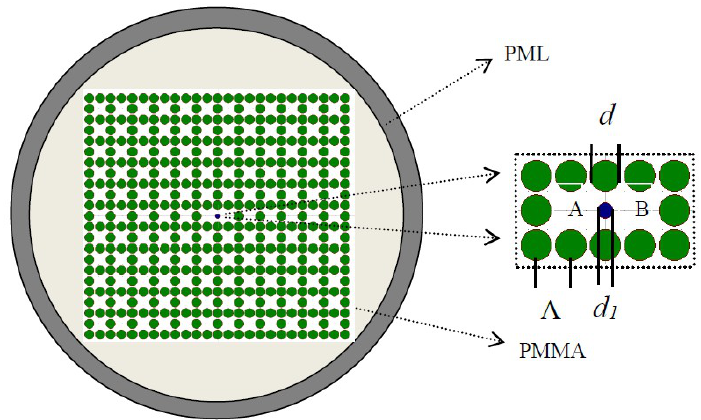
Figure 1. Cross-section of the proposed polymer optical fiber. The enlarged view of the core region is shown in the illustration.